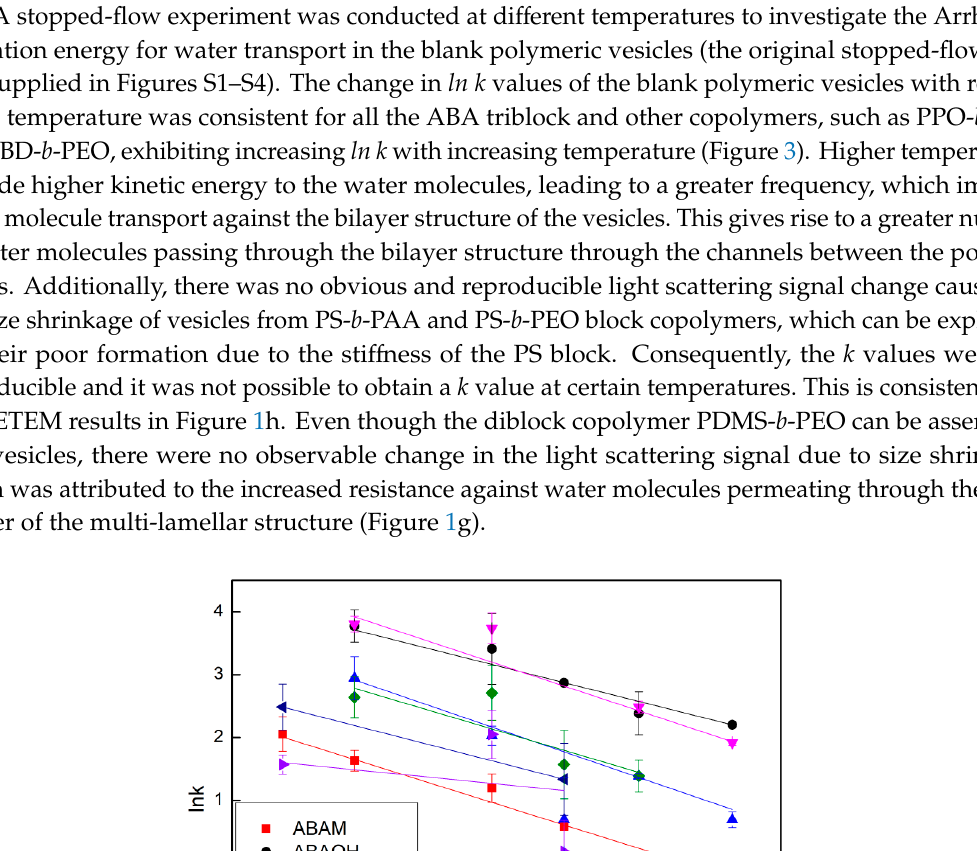
Figure 2. ( a ) Size and ( b ) zeta potential of various polymeric vesicles in deionized (DI)water (pH 7.4).